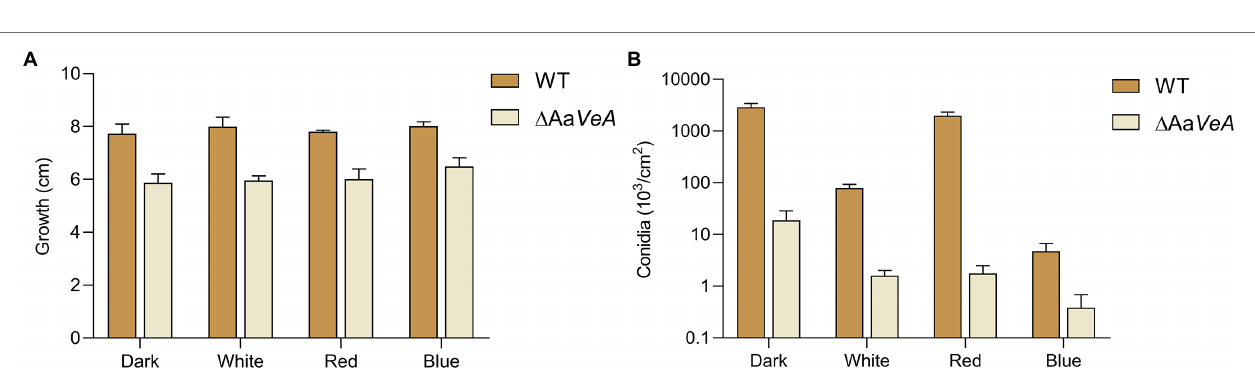
FIGURE 1 | Colony and morphology characters of the wild type (WT) and Aa VeA disrupted mutant ( Δ Aa VeA ) strains with various light sources in Alternaria alternata . (A) The front diagram of WT and Δ Aa VeA strains cultured on potato dextrose agar (PDA) for 10 days at 25 ° C in darkness (D) or with white (W), red (R) and blue (B) light. The colony of the wild strain extended at a similar rate while the mutant strain grew slower. The similar morphology was observed in the colony of the wild strain in darkness and with red light. However, the density of the mycelia became thicker in the wild strain with white and blue light. (B) Microscopic morphology of mycelia and spores of WT and Δ Aa VeA strains by scanning electron microscopy (SEM). The microscopic morphology of mycelial and spore structure was observed with no marked alteration in dark and light conditions. However, the fungal spores were much more abundant under dark and red-light conditions.